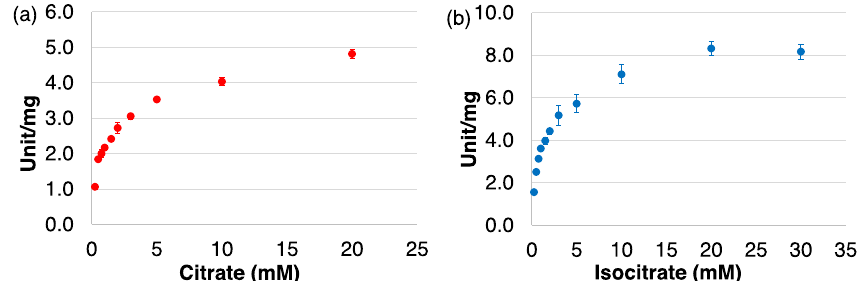
Figure 3. Saturation curves displaying the activities of Sy AcnB. The experiment was performed using ( a ) trisodium citrate dihydrate in Tris–HCl buffer pH 7.7 at 45 °C and ( b ) dl-isocitrate trisodium salt hydrate in Tris–HCl buffer pH 8.0 at 53 °C. Mean ± SD values were calculated from three independent experiments. Sy AcnB, Synechocystis sp. PCC 6803 aconitase B; SD, standard deviation.